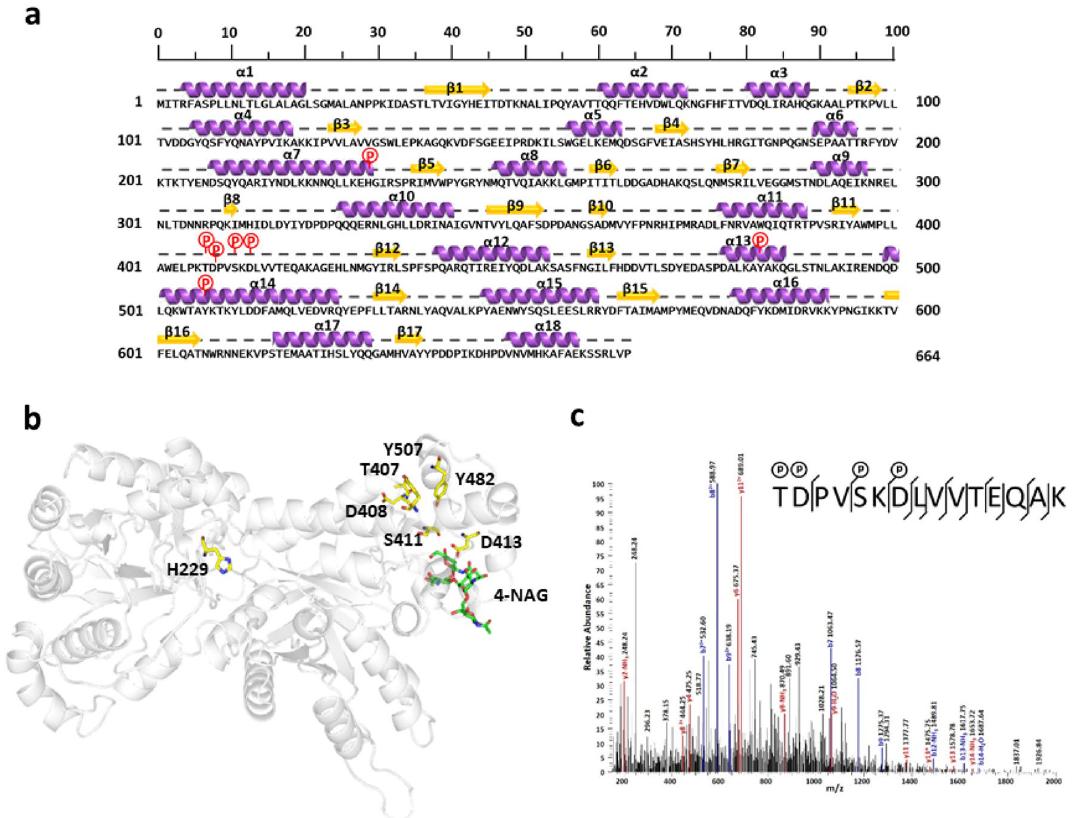
Figure 2. The identified phosphorylated sites on AbPgaB1 marked in secondary structure and tertiary structure. ( a ) The secondary structure of AbPgaB1 was predicted by Jpred4. Alpha helix and beta sheet structures were marked in purple and yellow, respectively. Identified p-sites were marked “p” (red) on AbPgaB1 sequences. ( b ) Tetrasaccharide of PNAG, 4-NAG, which the main chain showed in sticks (green) were docked into the AbPgaB1 modeled structure (cartoon, predicted based on template PDB: 4P7R 26 by SWISS-MODEL) to display the location of phosphorylated residues (yellow) within the 3D structure. The modeled structure was edited using PyMOL. ( c ) MS/MS spectra of p-peptide “ 407 TDPVSKDLVVTEQAK 421 ” on AbPgaB1. Each peak reveals the m/z of fragments after tandem mass spectrometry separation and is processed by MaxQuant. The N-terminal b-ion and C-terminal y-ion fragments were highlighted in blue and red, respectively.